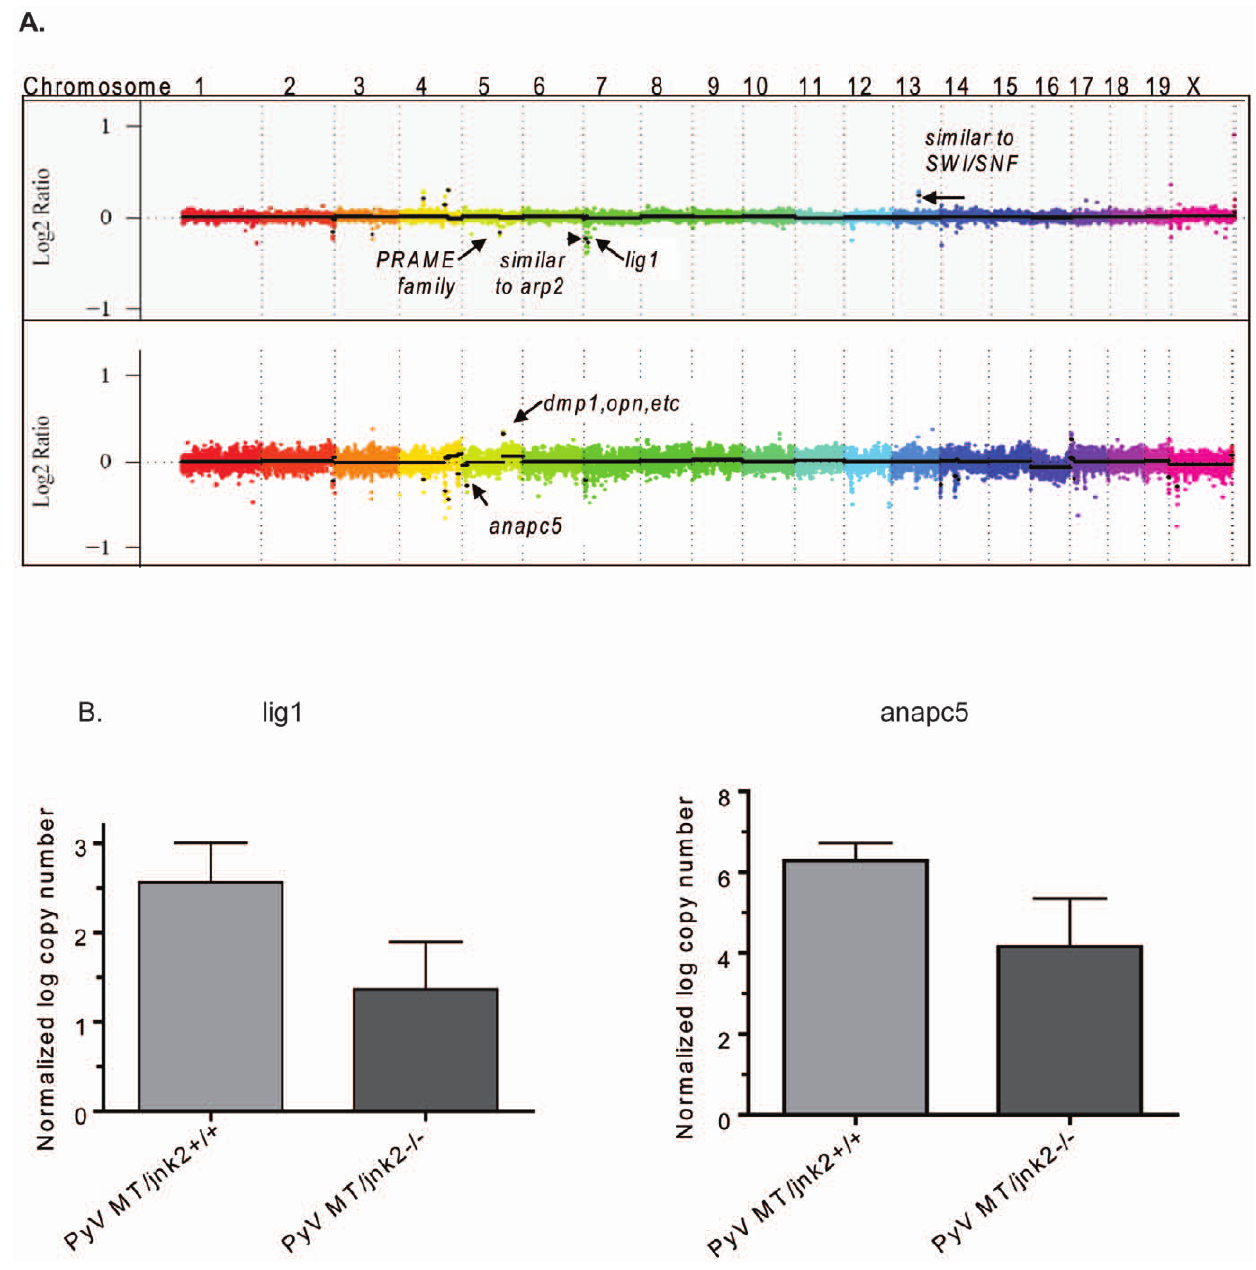
Figure 4. Chromosomal and gene expression changes occur in PyV MT/ jnk2 2 / 2 tumors. A ). aCGH analysis of PyV MT/jnk2 2 / 2 tumors show deletions in segments containing lig1, anacp5 and amplifications in dmp-1 , amongst others, compared to PyV MT/ jnk2 + / + controls; B ). Expression differences between PyV MT/ jnk2 + / + and PyV MT /jnk2 2 / 2 tumors were compared for lig1 and anapc5 using qPCR amplification and standard curves (n=5 per